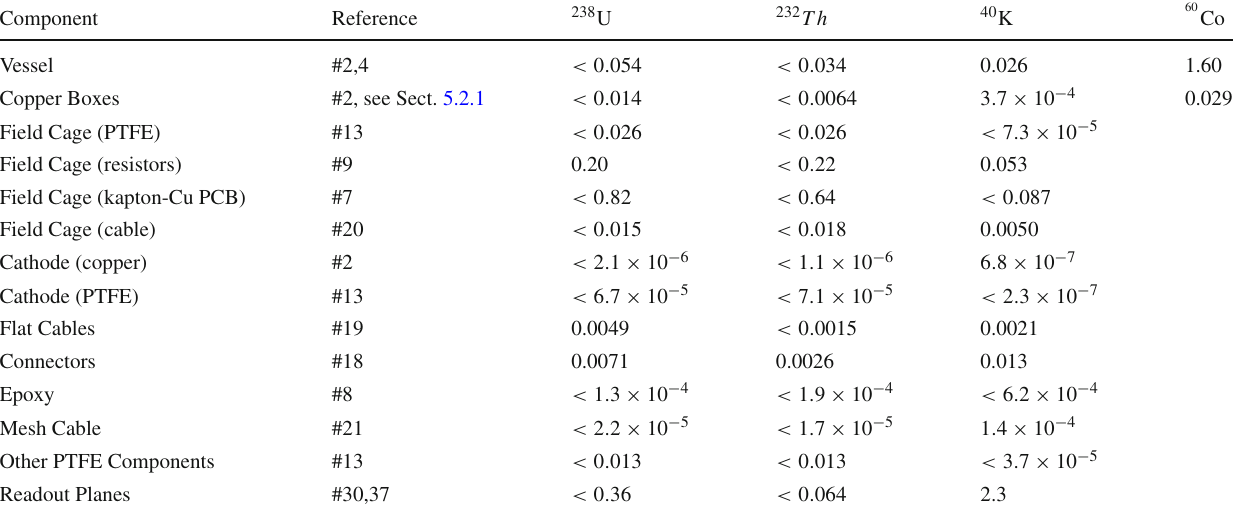
Table 3 Background rates (in counts keV − 1 kg − 1 day − 1 ) expected in the RoI (0.2-7 keV ee ) from the activity of each one of the considered contaminants in components using the Ne mixture in TREX-DM. The